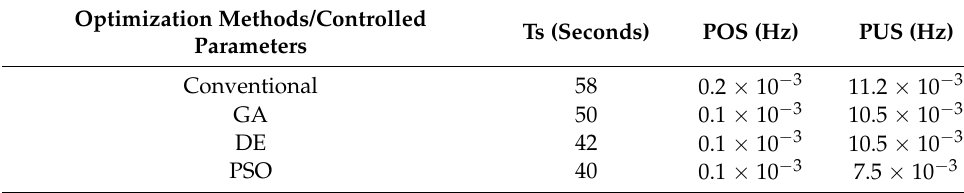
Table 5. Controlled parameters of delF using the IAE cost function.